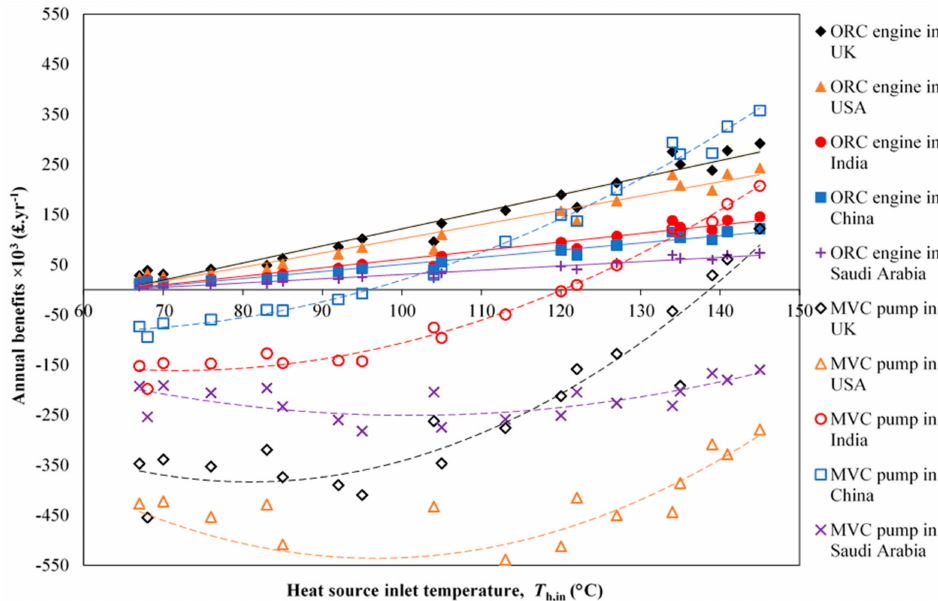
Figure 13. Annual monetary benefits resulting from use of ORC engines and MVC heat pumps in various countries as a function of the heat-source inlet temperature when utilizing the thermal energy available in the streams listed in Table 5. The heat sink is at 25 ◦ C for the ORC engines, and 150 ◦ C (LP steam) is produced for the MVC heat pumps.